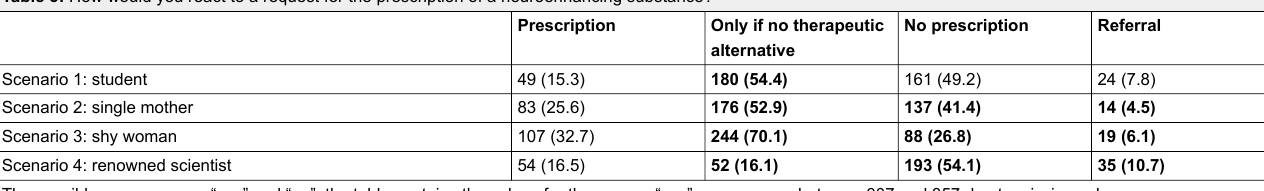
Table 3: How would you react to a request for the prescription of a neuroenhancing substance?